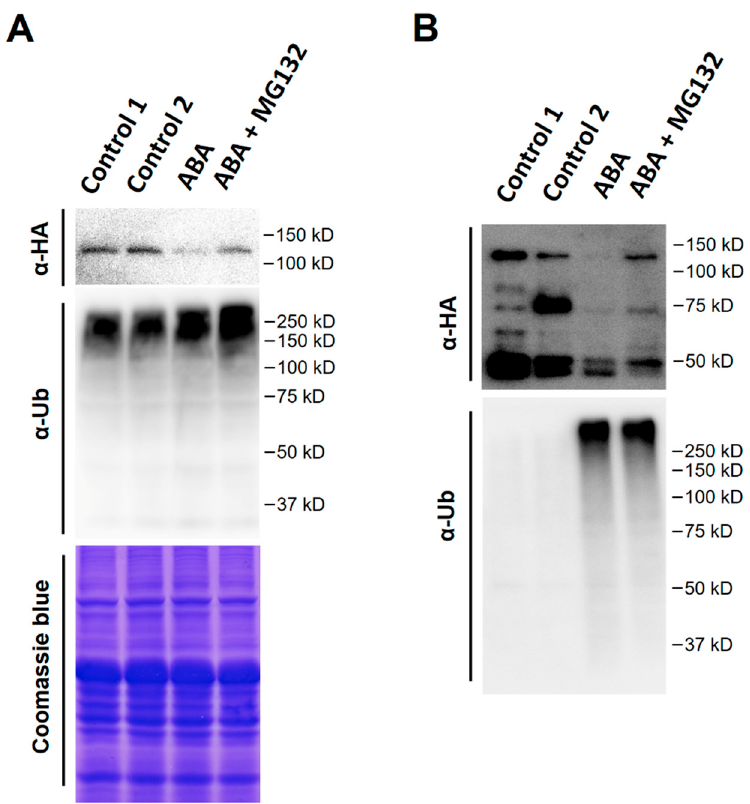
Figure 7. Effect of ABA treatment on the ubiquitination of HA-ARF6 . Transgenic HA-ARF6 seedlings were grown vertically in Petri plates. Seedlings (10-day old) were transferred to plates containing a filter paper and 5 mL half-strength MS with or without the treatment reagent. Each plate had about 25 seedlings. After 8 h of treatment, protein samples were prepared. ( A ) Western blotting using total protein samples (30 µ g protein per lane). The top panel shows the western blot with an anti-HA antibody, the second panel shows the western blot with an anti-Ub antibody, and the bottom panel shows gel staining with Coomassie blue. The treatment conditions are indicated directly above the lanes. Control 1: normal half MS medium; Control 2: half MS medium plus 0.1% ethanol and 0.1% DMSO; ABA: 50 µ M; MG132: 25 µ M. ( B ) Analysis of purified HA-ARF6. Total proteins (600 µ g for each sample) were used to purify HA-ARF6 with anti-HA agarose beads. The purified HA-ARF6 samples were used in western blotting. The top panel shows the western blot with an anti-HA antibody and bottom panel shows the western blot with an anti-Ub